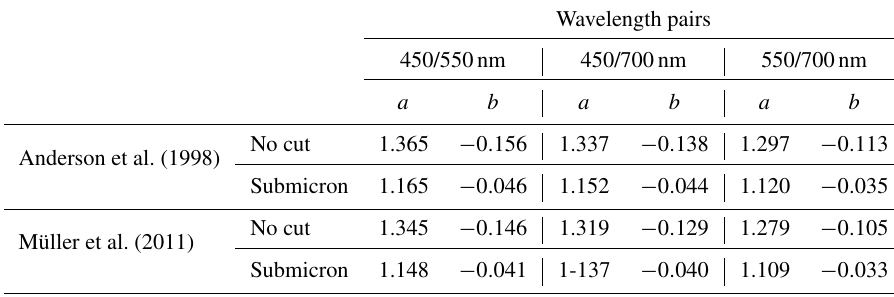
Table 4. Values for a and b for Eq. (5) for Anderson and Ogren (1998) and Müller et al. (2011).